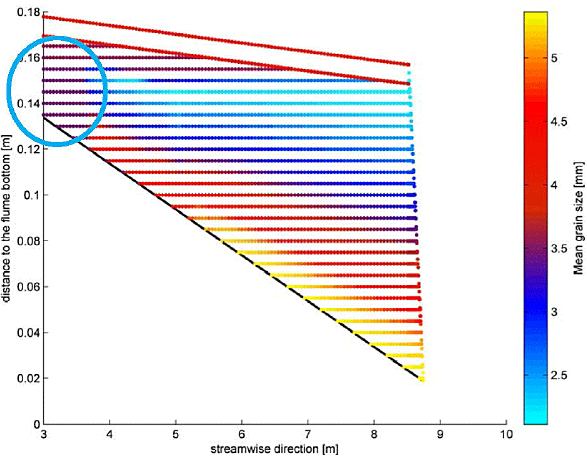
Figure 8. Numerical stratigraphy of the deposit. The dots represent the grid nodes, and the color scale is associated with the geometric mean diameter in millimeters of the substrate layers. The black line represents the top of the initial layer of parent material. The blue oval indicates the stratigraphy affected by the initial conditions.